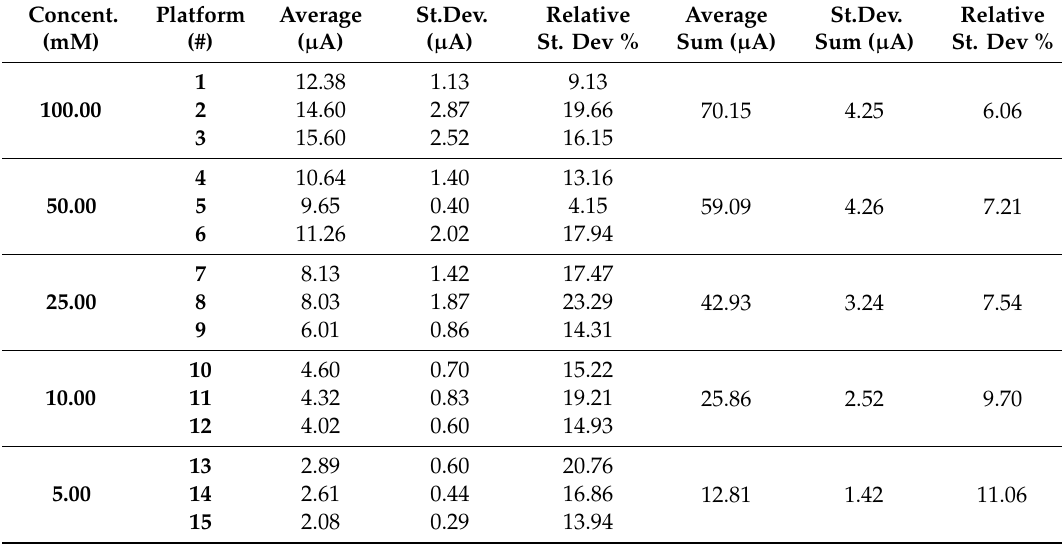
Table 3. Intra- and inter-platform